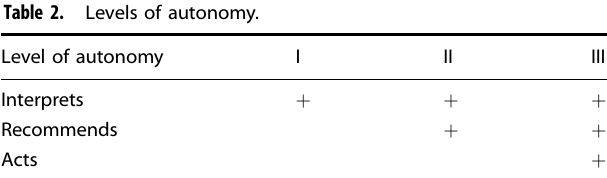
Table 2. Levels of